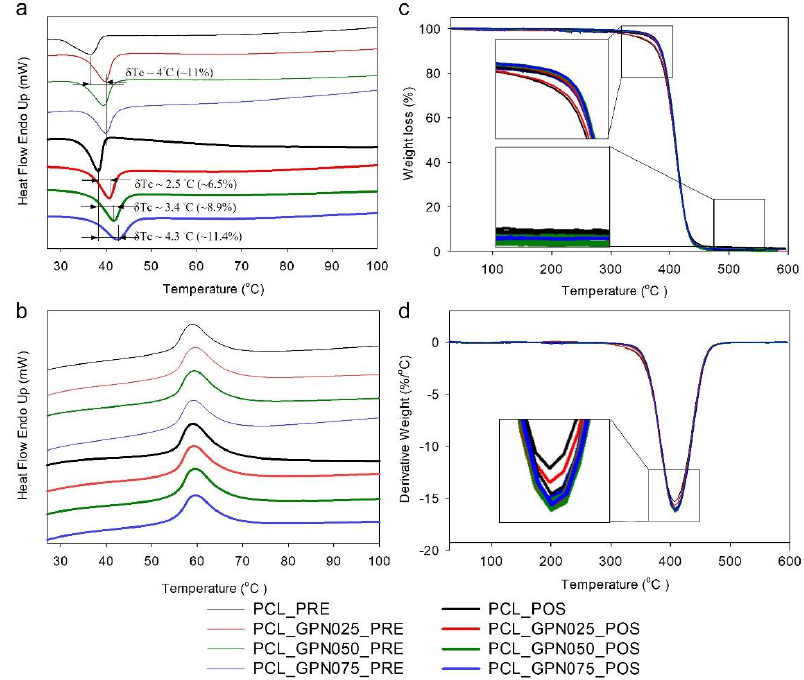
Figure 2. DSC ( left column) and TGA ( right column) results of the pre- and post-processed PCL/GPN composites: ( a ) DSC of first cooling cycle, ( b ) DSC of second heating cycle, ( c ) TGA curves, and ( d ) derivative of TGA curves. Table 2. Thermophysical properties of PCL-based composites obtained from DSC and TGA: Tc ; Tm ; ΔHm ; Xc ; ΔM ; P DTG . Two- way ANOVA, uncorrected Fisher’s LSD ( n = 3), multiple comparisons to a control (PCL). Statistical differences: ** p < 0.01; *** p < 0.001.